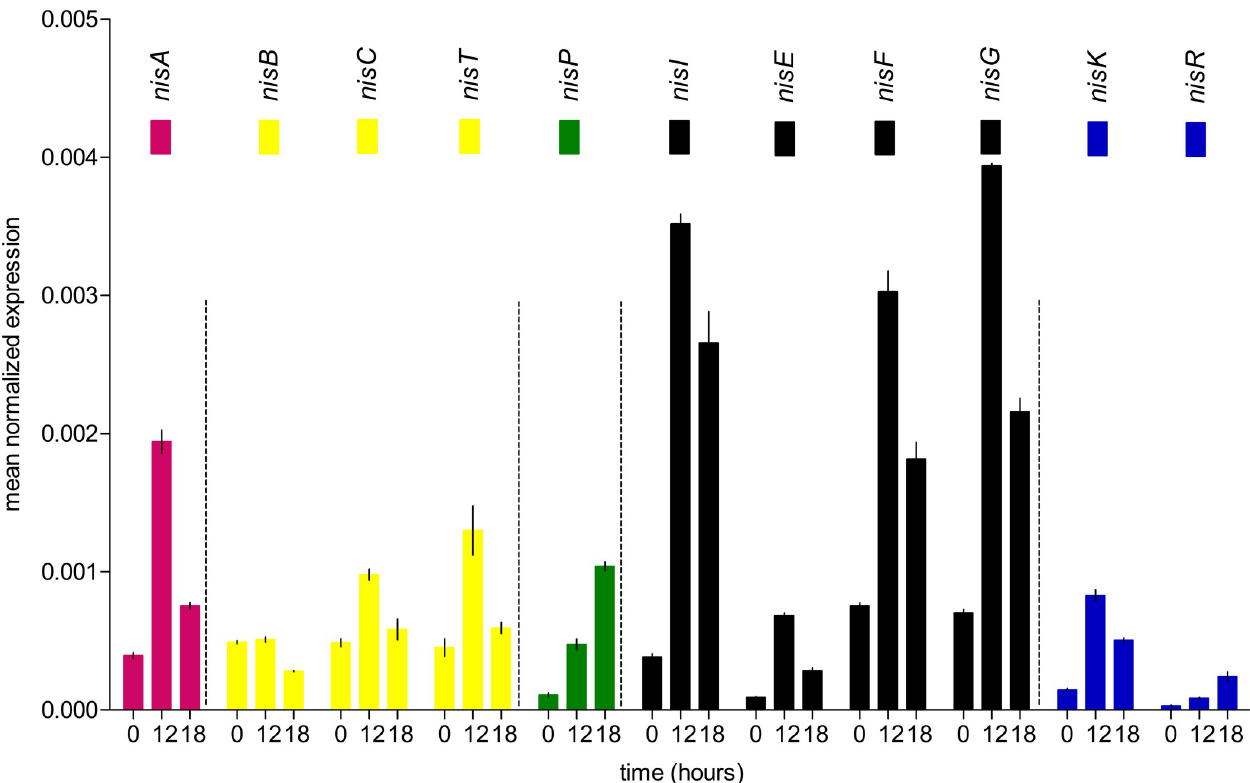
Fig 2. Transcriptional analysis of genes involved in the biosynthesis of nisin in the L . lactis subsp. lactis strain using qRT-PCR. For each condition, reactions were done in triplicate in three separate experiments. To standardize cycle threshold (Ct) results, the 16S rRNA gene was used as an internal control. The relative expression was expressed as ‘mean normalized expression’ data using Q-Gene software [43]. The bars represent means of three independent replicates ± standard error (P < 0.05).